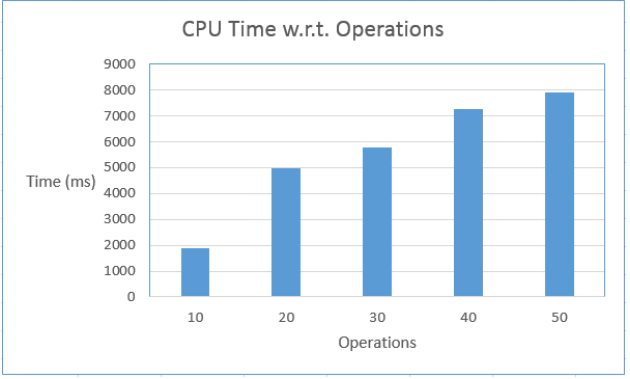
Figure 7. CPU time with respect to the number of operations (Problems 1~5).